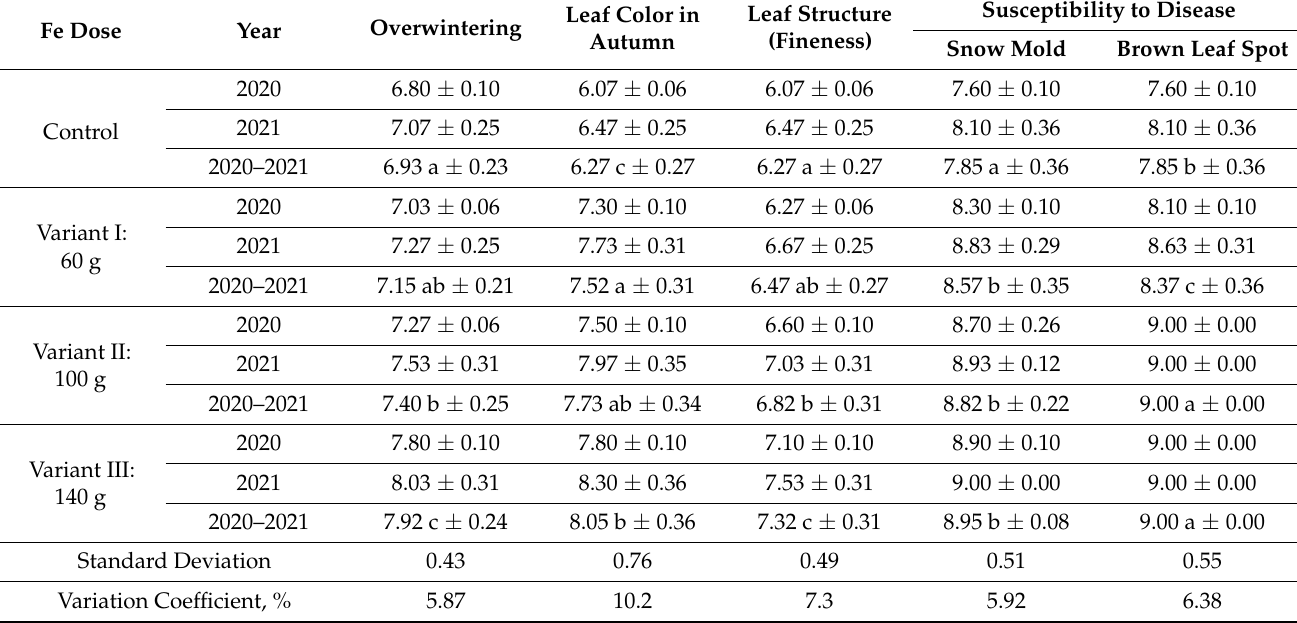
Table 3. Scores for minor lawn properties depending on fertilization variant.